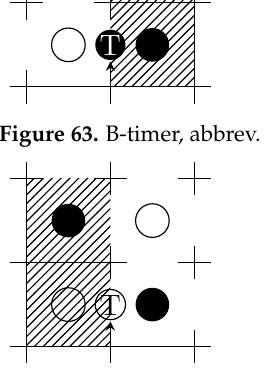
Figure 64. W-timer,